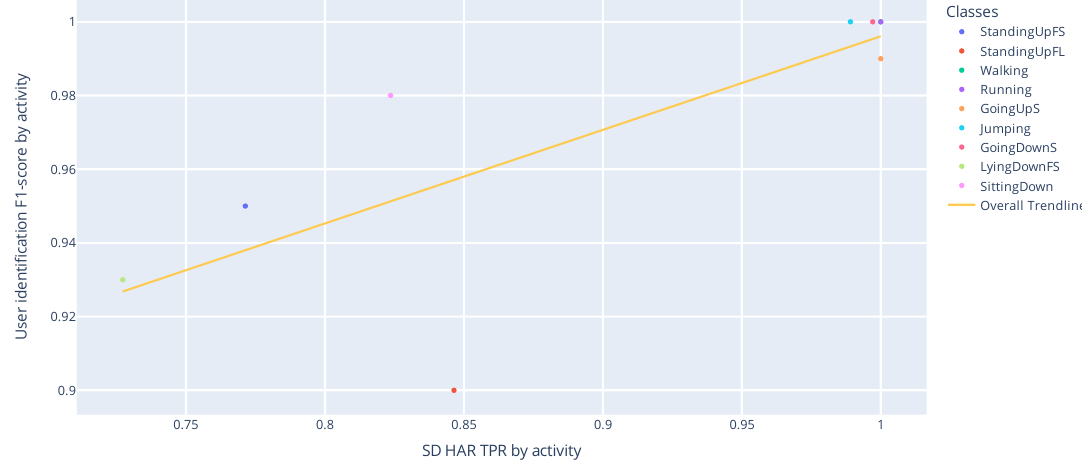
Figure 11. Correlation between the performance of user identification and SD HAR for ADLs.